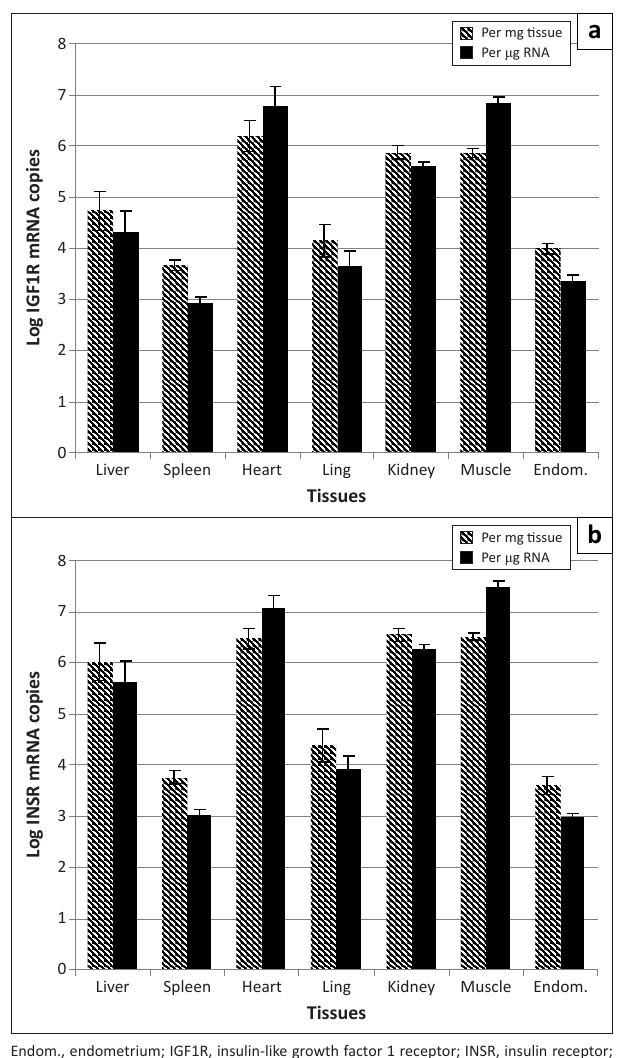
FIGURE 4: Mean log, (a) IGF1R (b) INSR mRNA copies per mg tissue (downward diagonal) and μ g RNA (black) ± standard